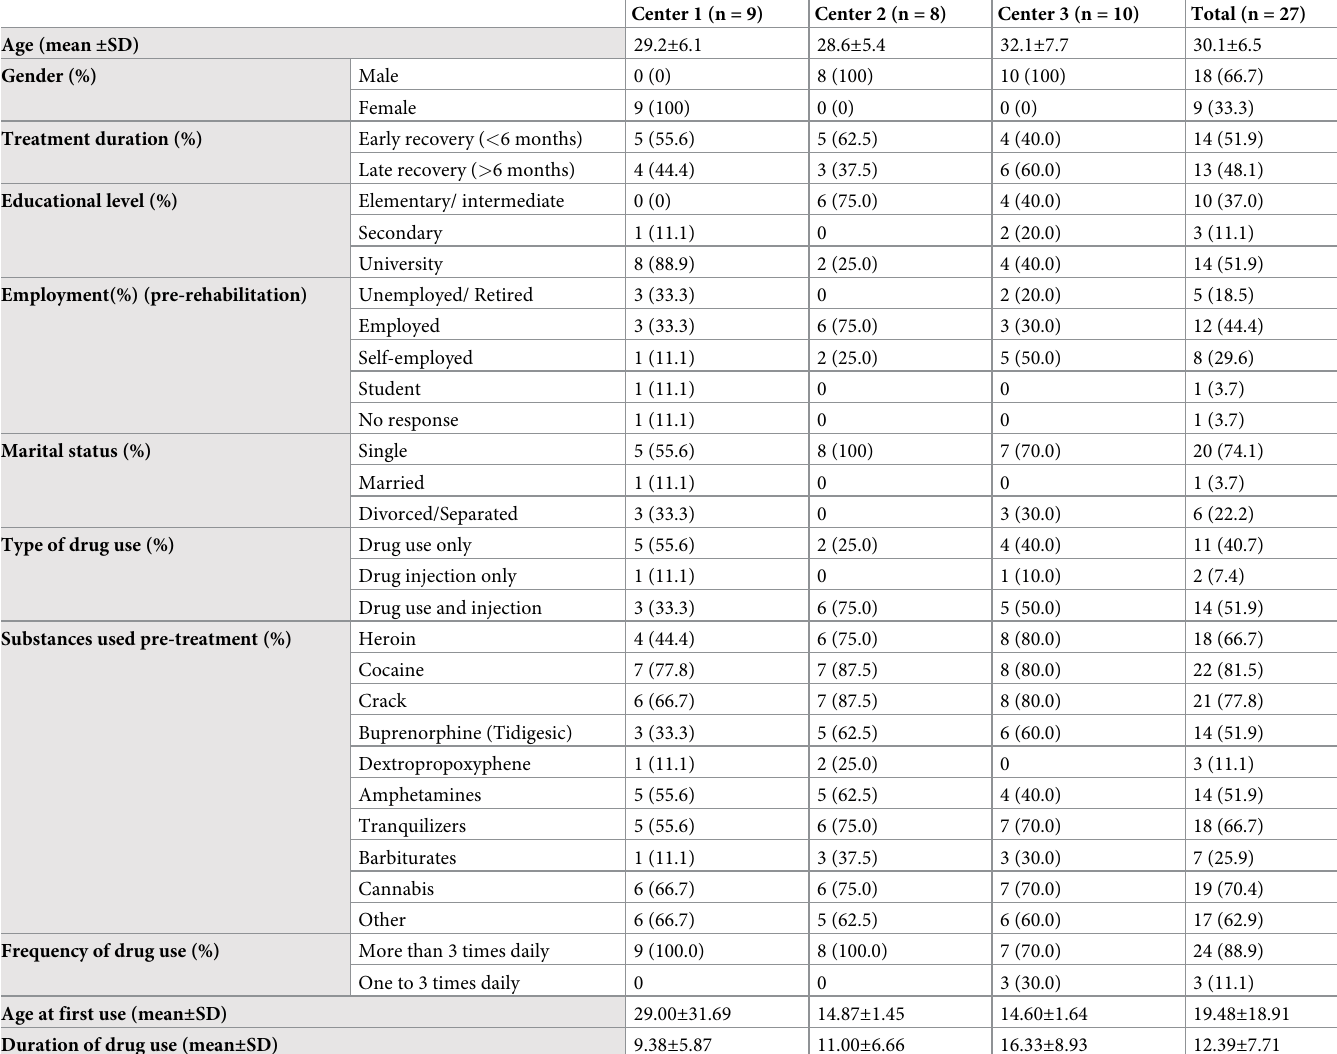
Table 1. Demographic information of participants of the Focus Group Discussions